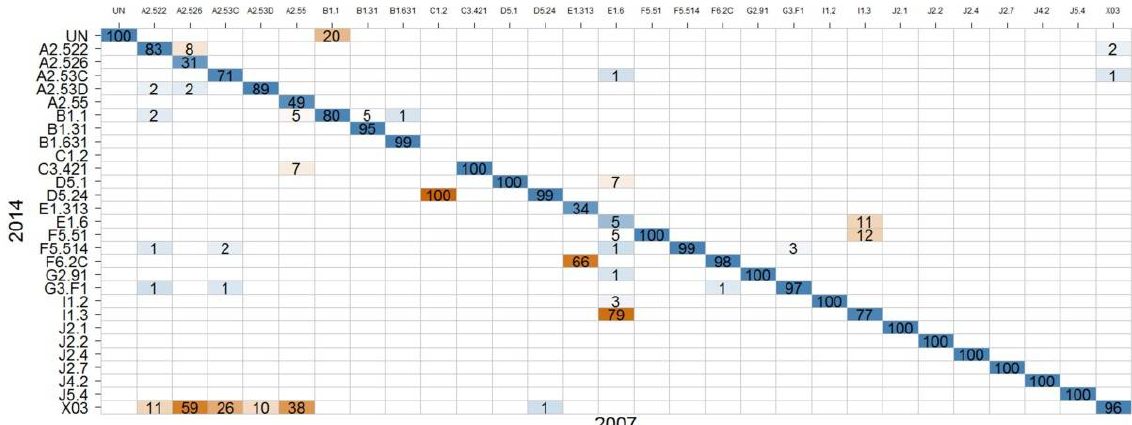
Figure 5. EUNIS habitat class transition matrix from 2007 to 2014 for the CE site.